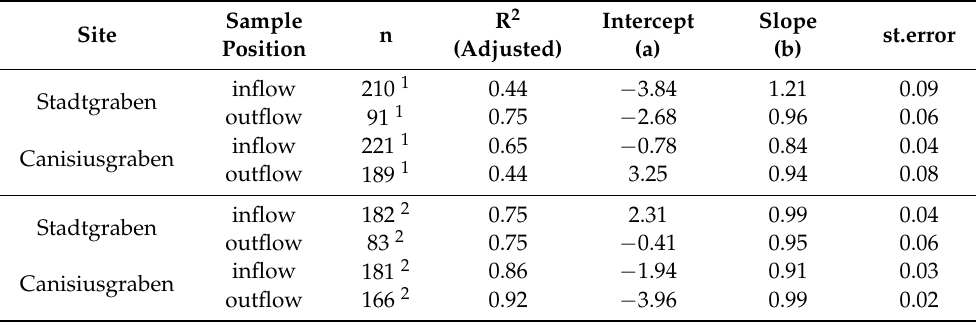
comparison of raw and adjusted